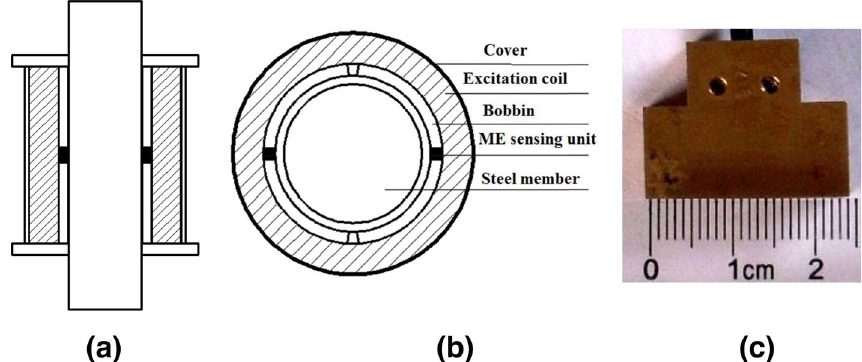
Fig. 1 Structure of an EME sensor: a vertical section view, b cross-section view, and c photo of the ME sensing